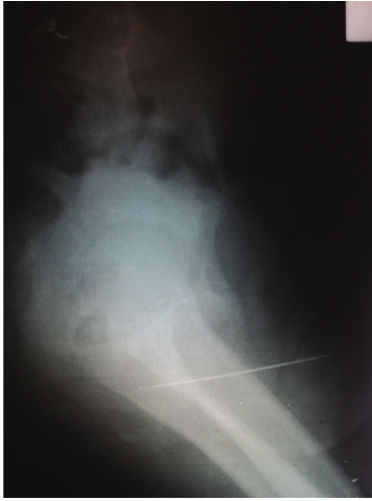
Figure 4: Lateral pelvic radiogram of case 2 revealed that FB was about 13 cm in